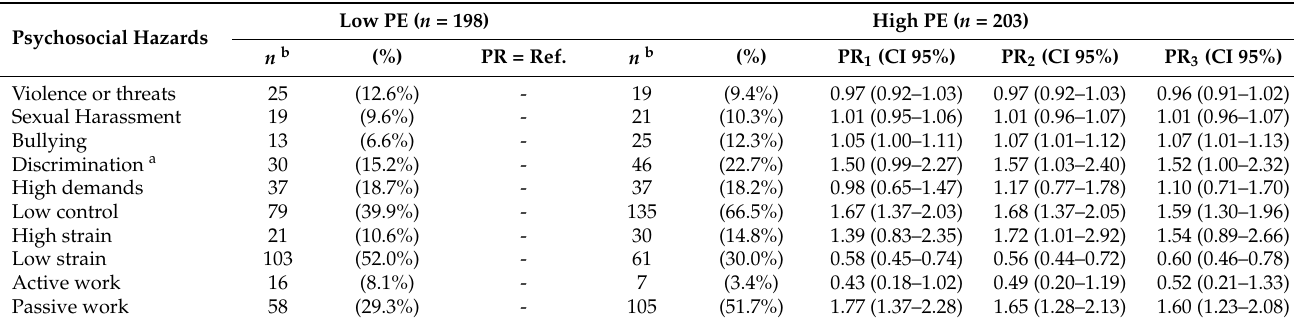
Table 2. Workplace violence, sexual harassment, bullying, discrimination, and job demands/control by low (reference group) and high precarious employment (PE). ( n =